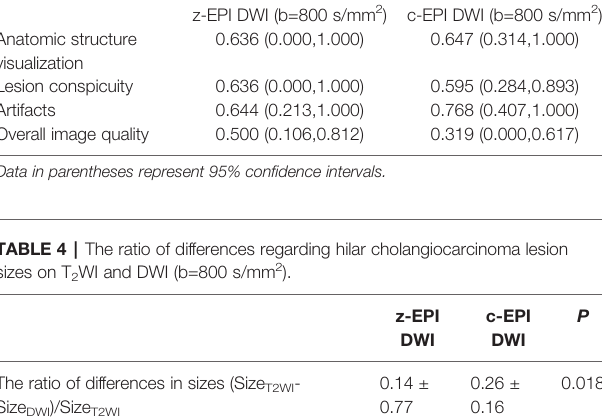
The ratio of differences in sizes (Size T2WI - Size